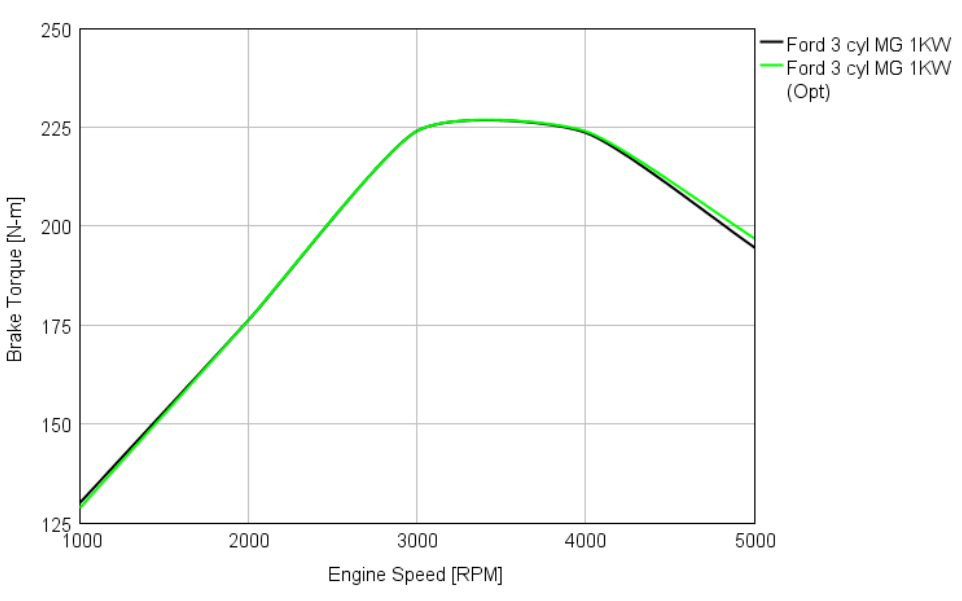
Figure 19. Brake torque over engine speed for the initial and the optimized EAT 1 kW models.